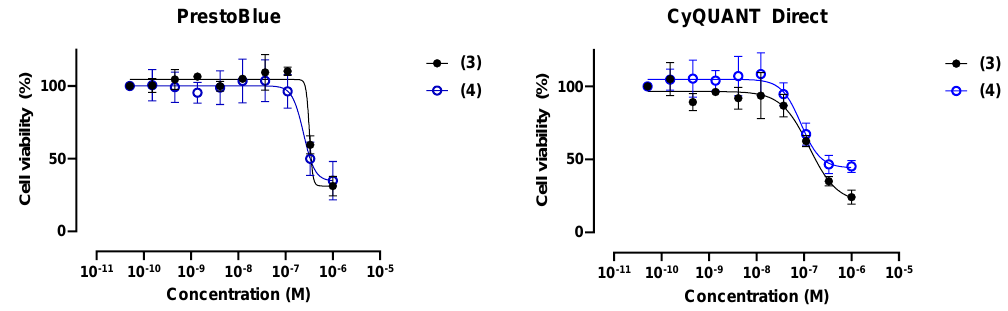
Figure 4. Percent viability of BxPC-3 human PDAC cells following 3 day exposure to trichoderin A ( 3 ) and its simplified analogue ( 4 ), as judged by the PrestoBlue™ and CyQUANT™ Direct assays. Intriguingly, there exists a precedence for this observation: the recent discovery of the leucinostatin Y by Kawada’s group was also reported alongside a comparative 2,5- diphenyl-2 H -tetrazolium bromide (MTT) assay against the parent peptide leucinostatin A ( 1 ) on the human PDAC cell lines PANC-1, BxPC-3, PSN-1, and PK-8 [21]. Their results indicated that ( 1 ) is selectively cytotoxic against all four cell lines, but only when they are cultured under minimal glucose in the growth medium. On this basis, we opted to re-evaluate the cytotoxicity of both trichoderins ( 3 ) and ( 4 ) against BxPC-3 and also PANC-1 under both ‘low glucose’ and ‘normal glucose’ conditions. Pleasingly, we were able to demonstrate evidence of selective toxicity under the ‘low glucose’ condition in both cell lines (Figure 5 and Table 1), and that the trichoderin A analogue ( 4 ) was similarly potent to the parent peptide ( 3 ), thereby validating our rationale for the replacement of AHMOD with Cha.